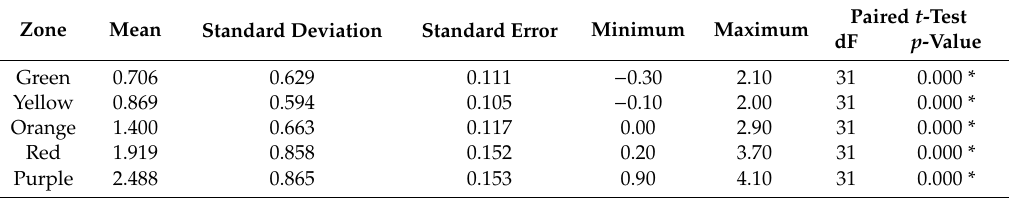
Table 7. Variation of forearm skin temperature ( ◦ C).